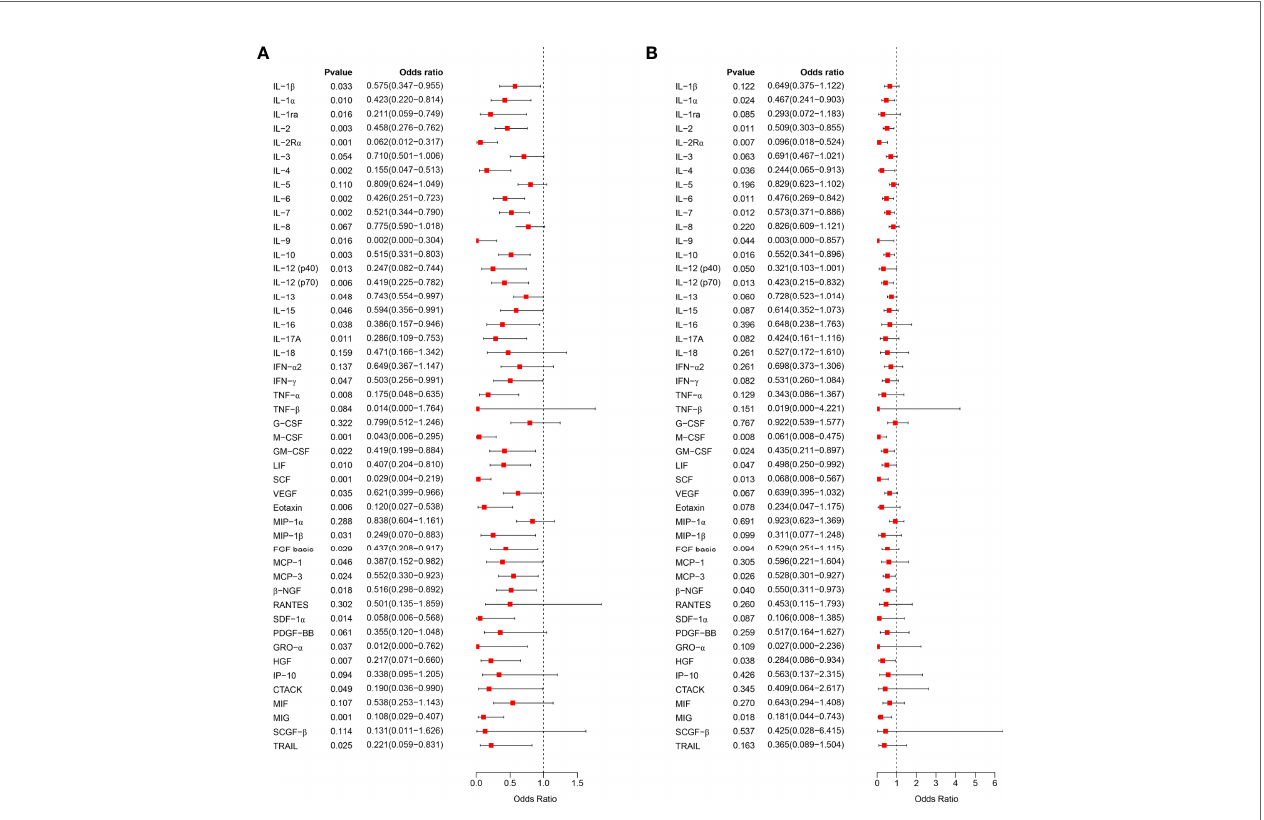
FIGURE 2 | Correlation analysis of early pregnancy serum cytokines and PIH. (A) , The relationship between the expression level of 48 cytokines in early pregnancy serum and the occurrence of PIH in later pregnancy was analyzed by univariate logistic regression analysis and visualized as a forest map. (B) , After correcting the mean arterial pressure before pregnancy, the relationship between the expression level of 48 serum cytokines in early pregnancy and the occurrence of PIH in later pregnancy was analyzed by logistic regression analysis. OR > 1 indicates a risk factor, and OR < 1 indicates a protective factor.